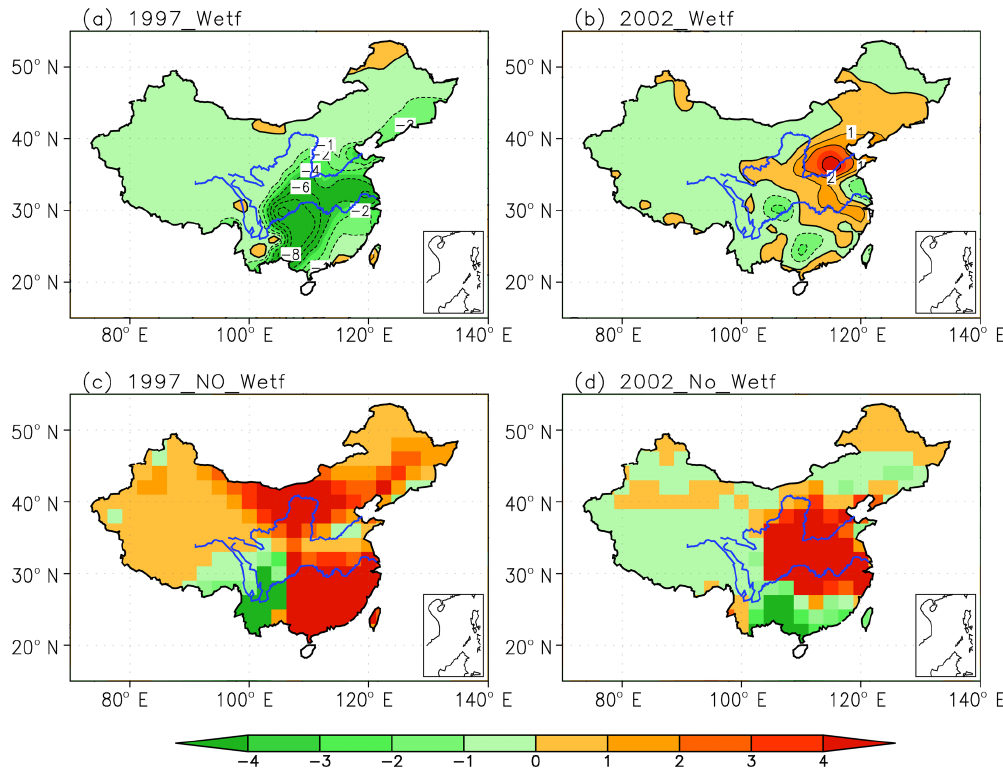
Figure 11. The spatial distribution of the vertically integrated wet deposition flux anomalies during the winters of (a) 1997 and (b) 2002. Panels (c, d) are as (a, b) but for the anomalous distribution of aerosol concentrations when wet deposition is turned